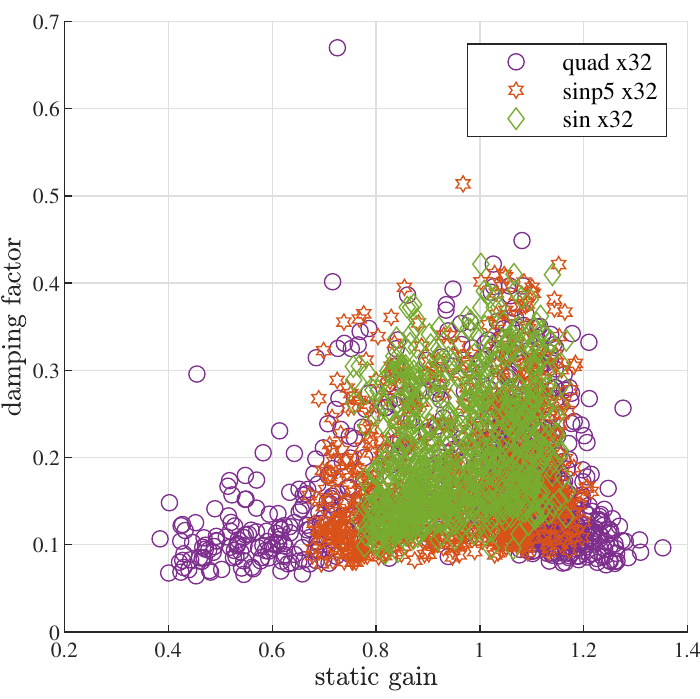
Figure 23. Scatter plot of damping factor against static gain for chosen microstepping